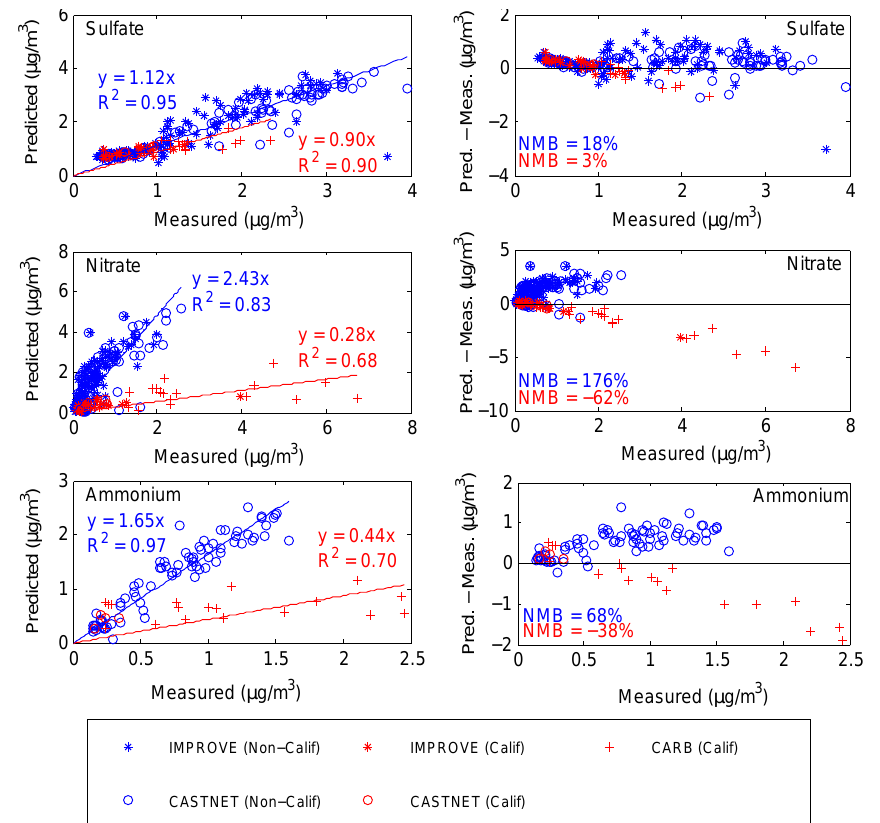
Fig. 6. Predicted versus measured annual mean concentrations (left panels) and difference between predicted and measured versus measured annual mean concentrations (right panels) for 2009. Each data point corresponds to an observed concentration at a measurement site along with the predicted concentration in the GEOS-Chem grid box containing the measurement site. Measured concentrations are IMPROVE (PM 2 . 5 ), CASTNET (TPM), and CARB (PM 2 . 5 ). Red regression lines and normalized mean biases (NMB) are for California sites only. Blue regression lines and NMB are for all sites excluding California. Coefficients of determination, R 2 , calculated for regression through the origin (Montgomery et al.,